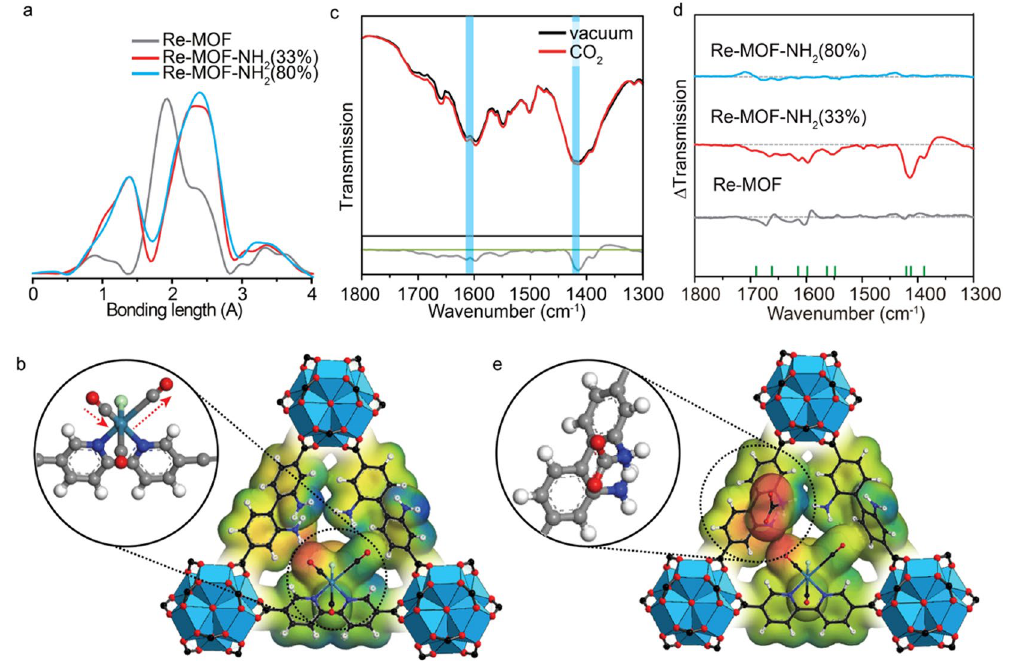
Figure 4. Characterization of the photocatalytic conversion mechanism in Re-MOF-NH 2 (33%). ( a ) EXAFS spectra for Re-MOF, Re-MOF-NH 2 (33%) and Re-MOF-NH 2 (80%). ( b ) Electrostatic potential diagram for Re- MOF-NH 2 (33%) where the ReTC inside is asymmetric. ( c ) IR spectra of Re-MOF-NH 2 (33%) under vacuum and CO 2 atmosphere. ( d ) Difference IR spectra of Re-MOF, Re-MOF-NH 2 (33%) and Re-MOF-NH 2 (80%) in the presence of CO 2 . ( e ) Electrostatic potential diagram of the intermolecular stabilization of carbamate by the